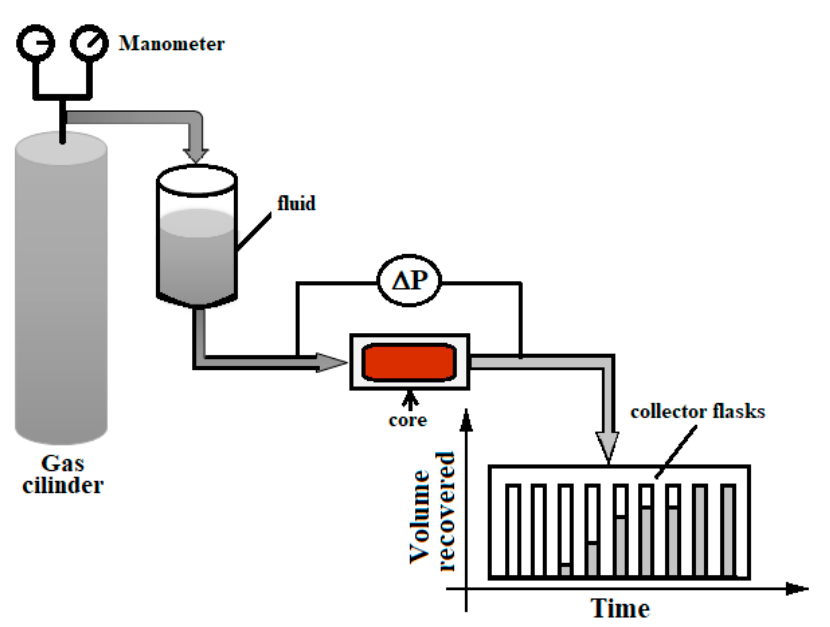
Figure 1. Experimental apparatus for oil recovery.